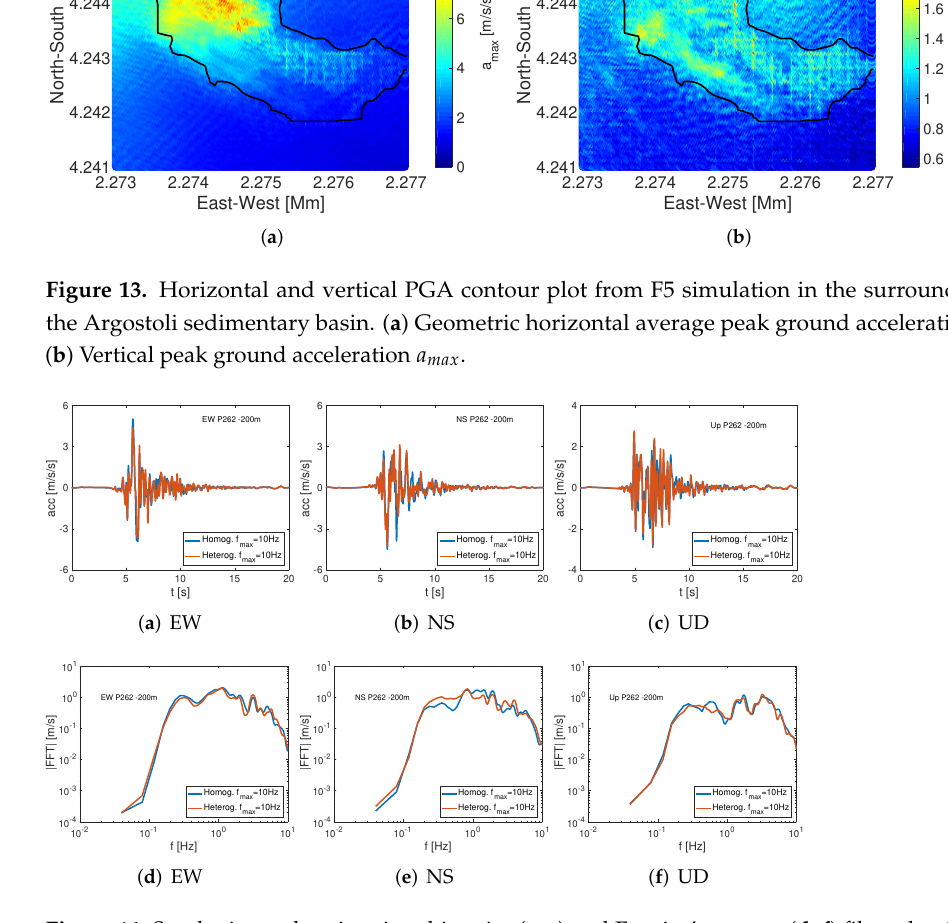
Figure 14. Synthetic acceleration time-histories ( a – c ) and Fourier’s spectra ( d – f ) filtered at 0–10 Hz, at P262 ( 200 m G.L.) obtained in O2 simulation. Comparison between homogeneous (blue) and − heterogeneous (red)